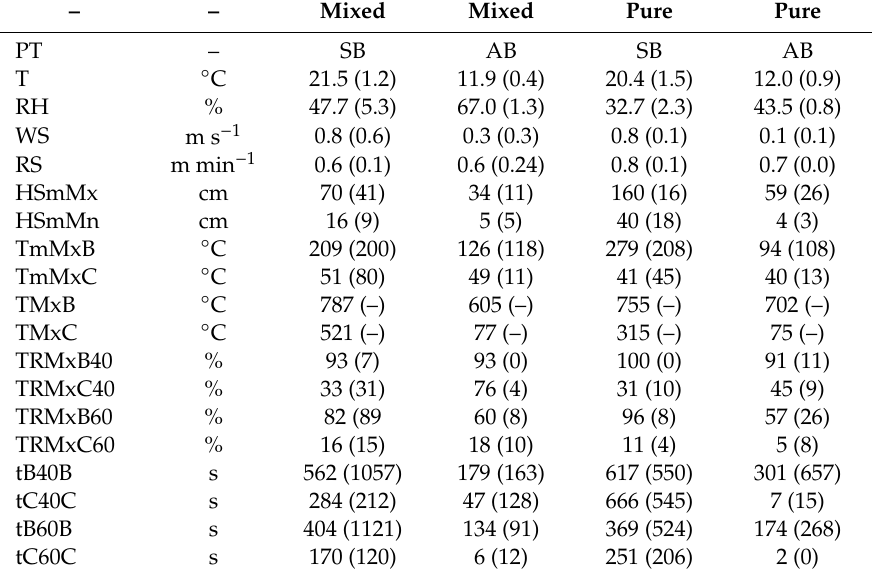
Table 3. Variables measured during and after prescribed burning in mixed and pure stands (mean and standard